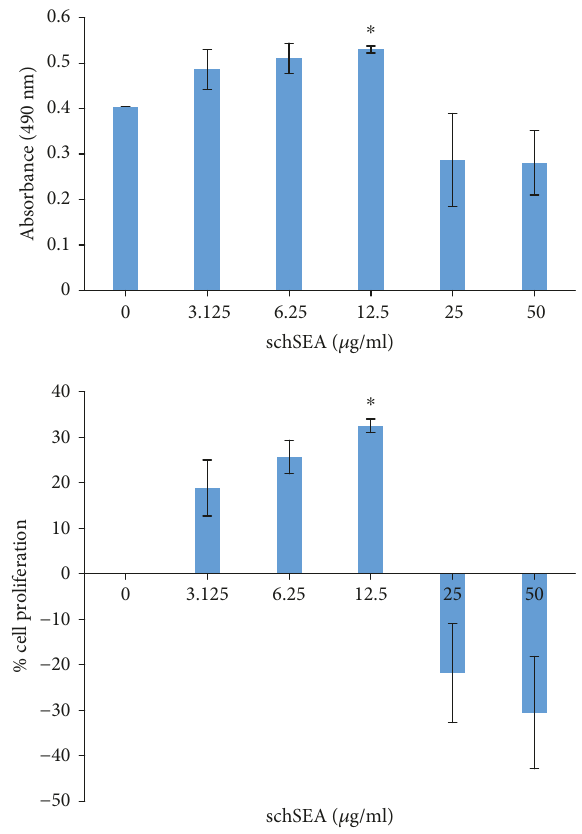
Figure 3: schSEA induces proliferation of prostate (PNT2). Statistical signi fi cance by Student ’ s t -test: ∗ p ≤ 0 05 (non-schSEA treatment vs. 12.5 μ g/ml schSEA-treated cells). Results are representative of three independent